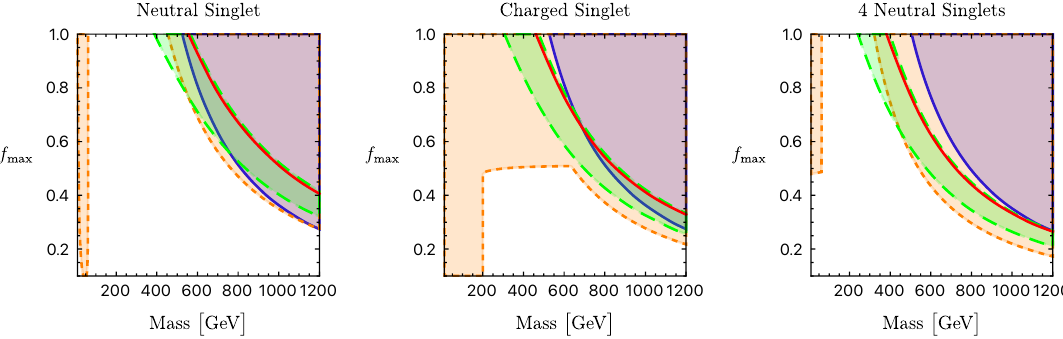
Figure 2 . The allowed parameter space based on the projections for near-future colliders. We use the one-sigma projections for the FCC-ee at 240 GeV from [63], doubled to give an estimate of the two-sigma bound; other colliders, such as ILC and CLIC, have comparable projections [63]. Labels are as figure 1. The two principal constraints are hγγ , which comes down from the top in the middle panel, for which the projected two-sigma constraint is 2 . 6% ; and the Higgs cubic self-coupling, which comes in from the left in the figure, for which the projected two-sigma constraint is 38%